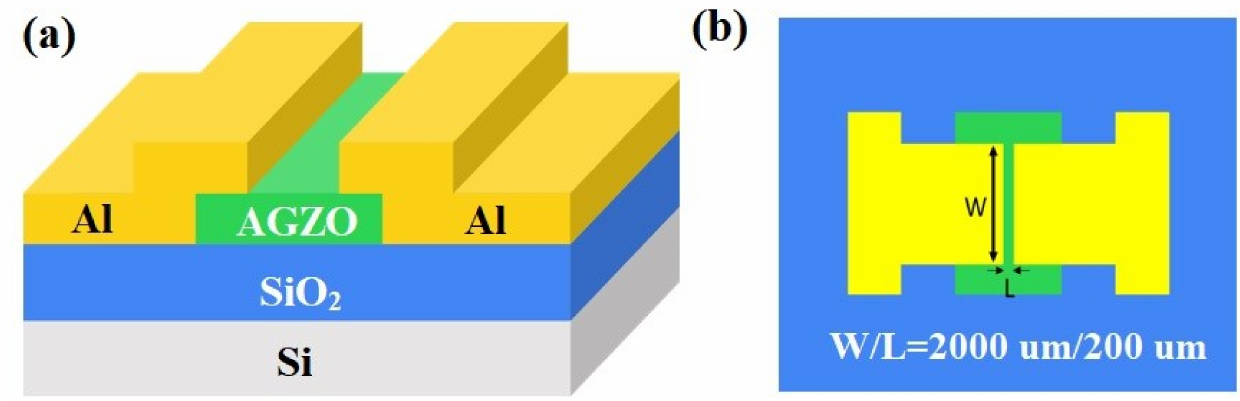
Figure 1. ( a ) Schematic structure of AlGaZnO phototransistor; ( b ) Top view of the